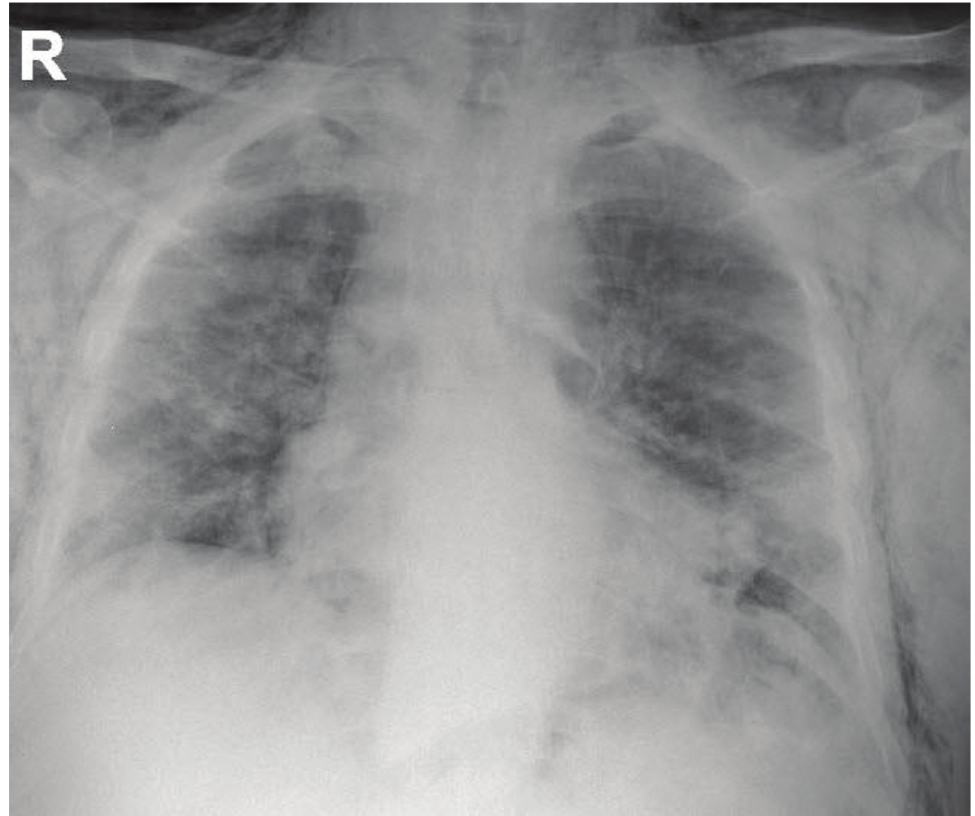
Figure 1 - Diffuse subcutaneous emphysema and bilateral parenchymal diffuse ground glass appearance on posteroanterior chest radiography.